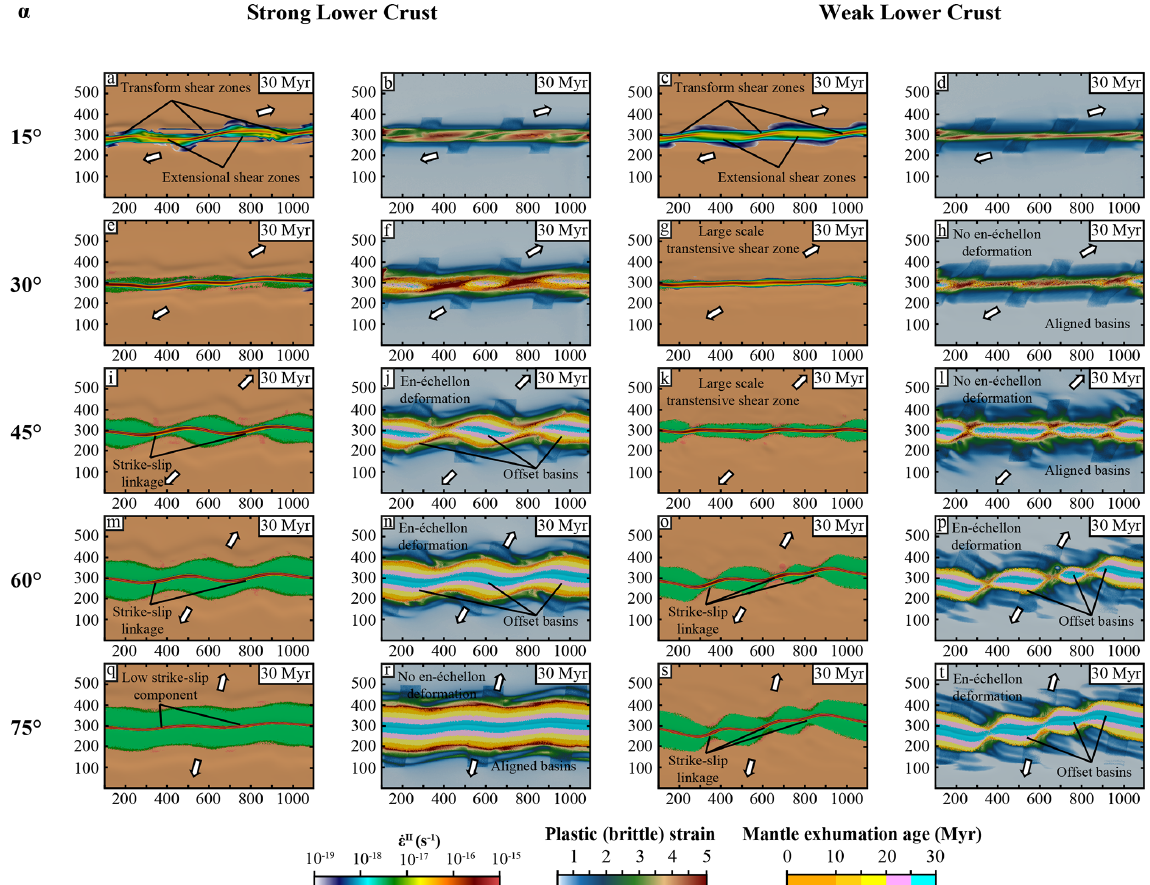
Figure 9. Map view of the 2km × 2km × 2km resolution models at 30Ma. The two left columns display the strong-lower-crust models, while the two right columns display the weak-lower-crust models. For each model the second invariant of the strain rate tensor and the plastic strain and mantle exhumation age are